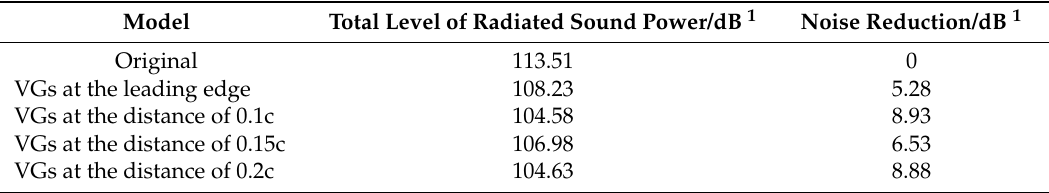
Table 3. The total level of radiated sound power from the different models.